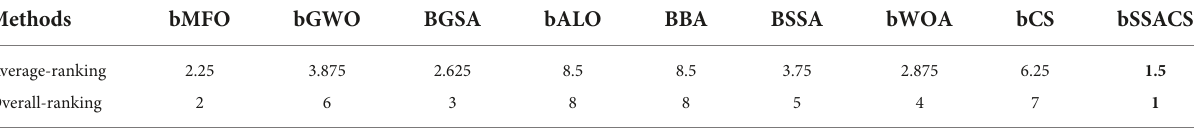
TABLE 12 The ranking of bSSACS-KELM and its peer